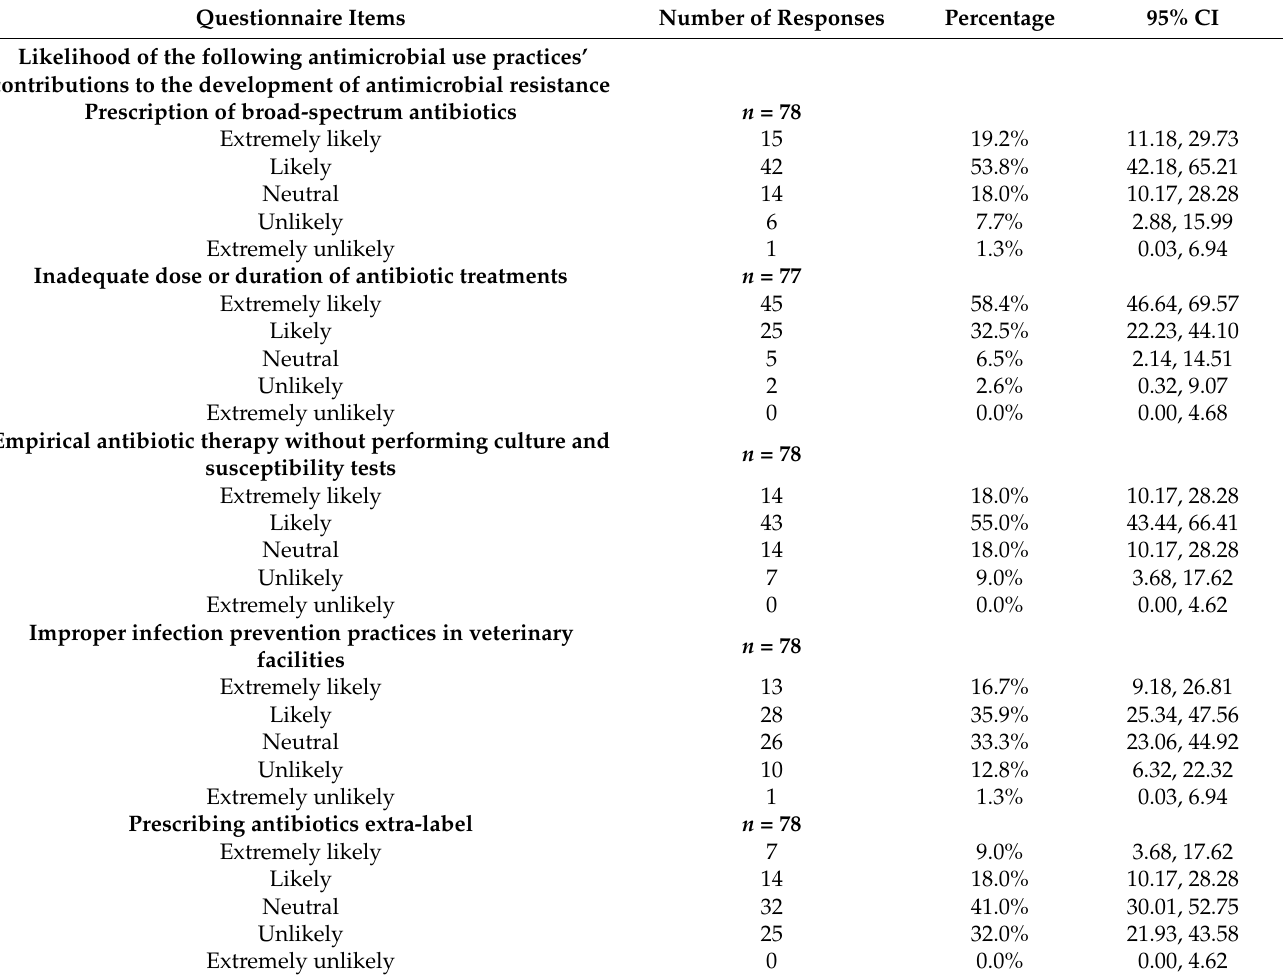
Table 3. Opinion of Illinois small animal veterinarians on the possibility of different antimicrobial use practices’ impact on the selection of antimicrobial